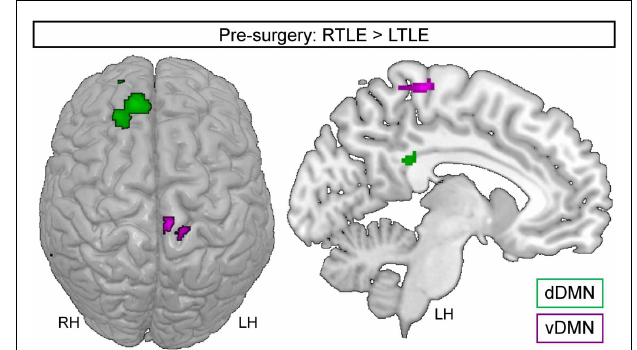
FIGURE 3 | Regions showing increased engagement in RTLE, relative to LTLE group, for the dorsal DMN (green) or the ventral DMN (purple). The images are shown in radiological orientation [e.g., the right side is the left hemisphere (LH)]. LH, left hemisphere; RH, right